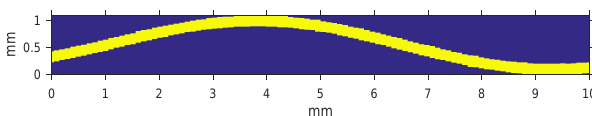
Figure 1. Visualization of gridpoints showing diffrac- tion on the sample. One pixel corresponds to one image, axes have equal scale.